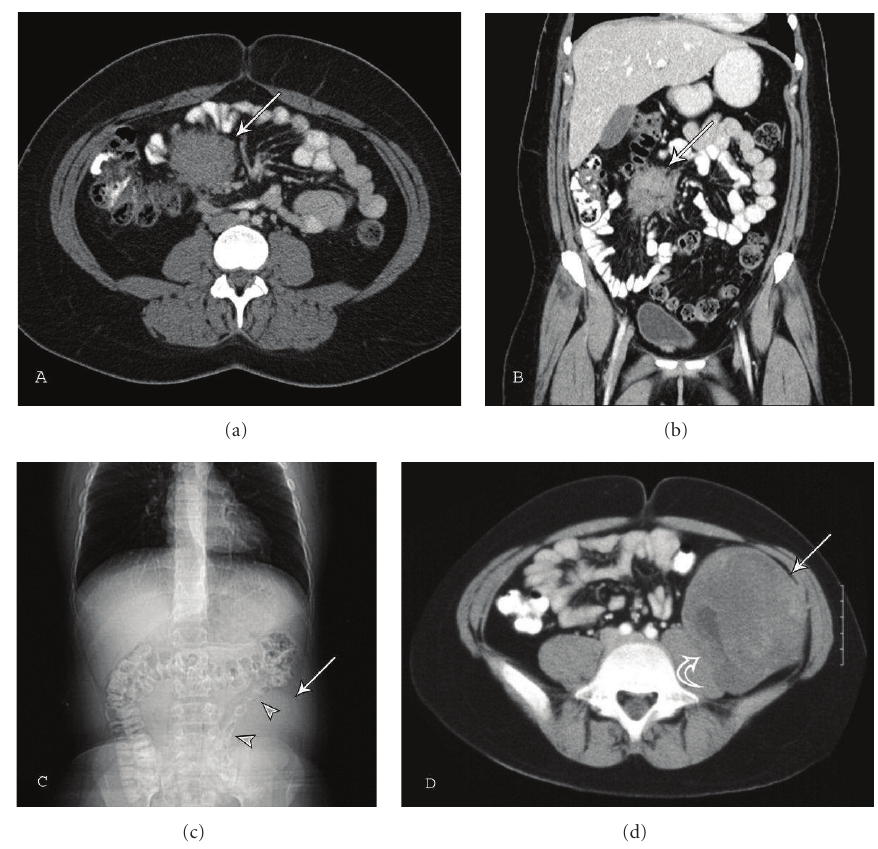
Figure 11: Intraabdominal fibromatosis. Mesenteric fibromatosis: a 29-year-old female with right-sided flank pain. (a) Axial and (b) coronal CT images demonstrate a mass (arrows) in the small bowel mesentery with irregular margins and attenuation similar to skeletal muscle. The mesenteric fat surrounds the lesion outlining the extent. Retroperitoneal fibromatosis: a 12-year-old male with a mass palpated in the left lower quadrant on routine physical exam. (c) CT topogram reveals an intraabdominal soft tissue mass (arrow) displacing the descending colon (arrowheads). (d) Axial CT shows a large retroperitoneal heterogeneous lesion (arrow) causing mass e ff ect on the left psoas muscle (curved arrow) with scattered areas of mild-to-moderate